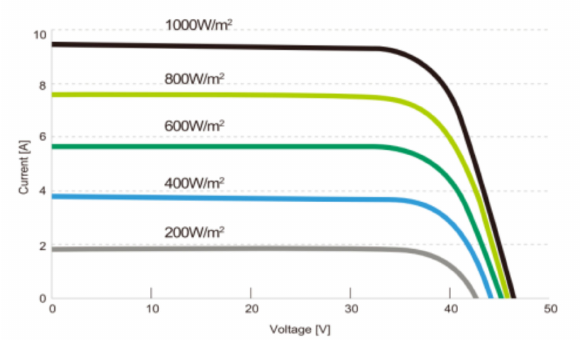
Figure 2. I-V curves of the target